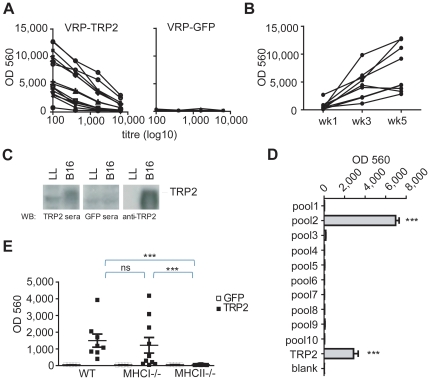
VRP-TRP2 elicits a TRP2-specific antibody response.(A,B) Measurement of TRP-2-specific serum IgG by ELISA. (A) Serial dilutions of sera from mice immunized with VRP-TRP2 (left panel) or VRP-GFP (right panel). Each line represents an individual mouse. (B) 1∶100 dilution of sera from mice immunized with VRP-TRP2 one week after the first (week 1), the second (week 3) or the third vaccination (week 5). Each line represents an individual mouse. (C) Western blot analysis of sera from VRP-TRP2 or VRP-GFP immunized mice and a commercial TRP-2 specific antibody (anti-TRP2) against B16 or Lewis Lung (LL) cell lysates. (D) Measurement of TRP-2-peptide specific serum IgG by ELISA. 1∶100 dilution of sera from mice immunized with VRP-TRP2 were tested against the indicated TRP-2 peptide pools. (E) 1∶100 dilution of sera drawn from WT, MHC I or MHC II deficient mice immunized with VRP-TRP2 or VRP-GFP were analyzed. Each dot represents sera from individual mice. *** P<0.0001.